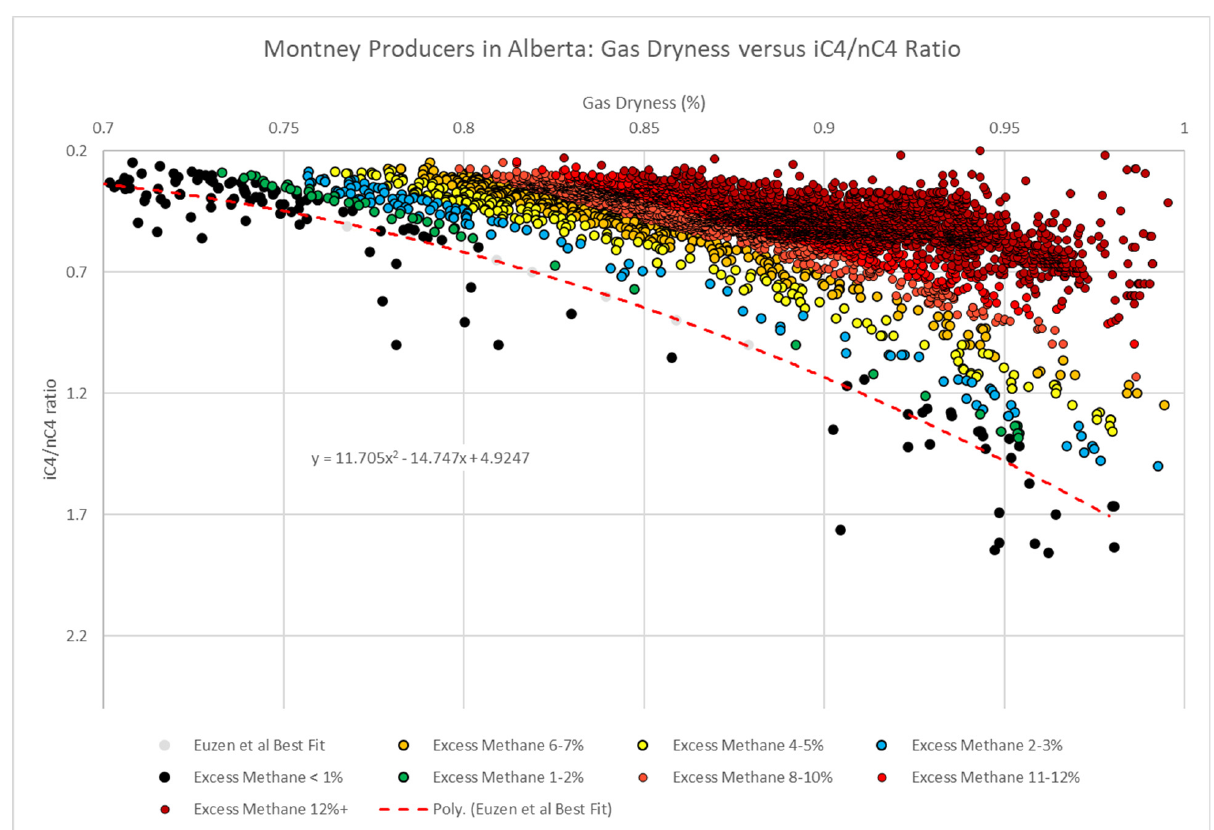
Figure 37. Cross plot of gas dryness and the iC4/nC4 ratio for all Alberta Montney producers at the time of this study. The iC4/nC4 is used as a maturity indicator with the line best representing the regional maturation trend from [4]. An excess methane percentage was calculated from the deviation away from the expected gas composition of the regional maturation trend. Wells that have high excess methane (i.e., red colours) have a greater ex situ gas content compared to wells noted by black symbols. Wells represented by black or green symbols have low ex situ gas contents, and the hydrocarbons are the result of in situ generation that is typical of a self-sourcing reservoir. The Alberta Montney producers have a greater contribution of migrated gas than the BC wells.